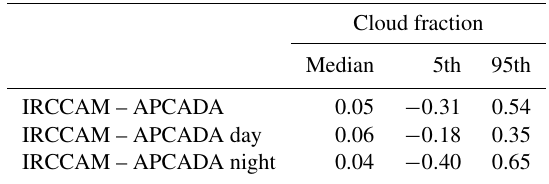
Table 5. Median and 5th and 95th percentiles of the differences in calculated cloud fractions from IRCCAM versus APCADA: over- all, daytime only and night-time only. The numbers are in the range